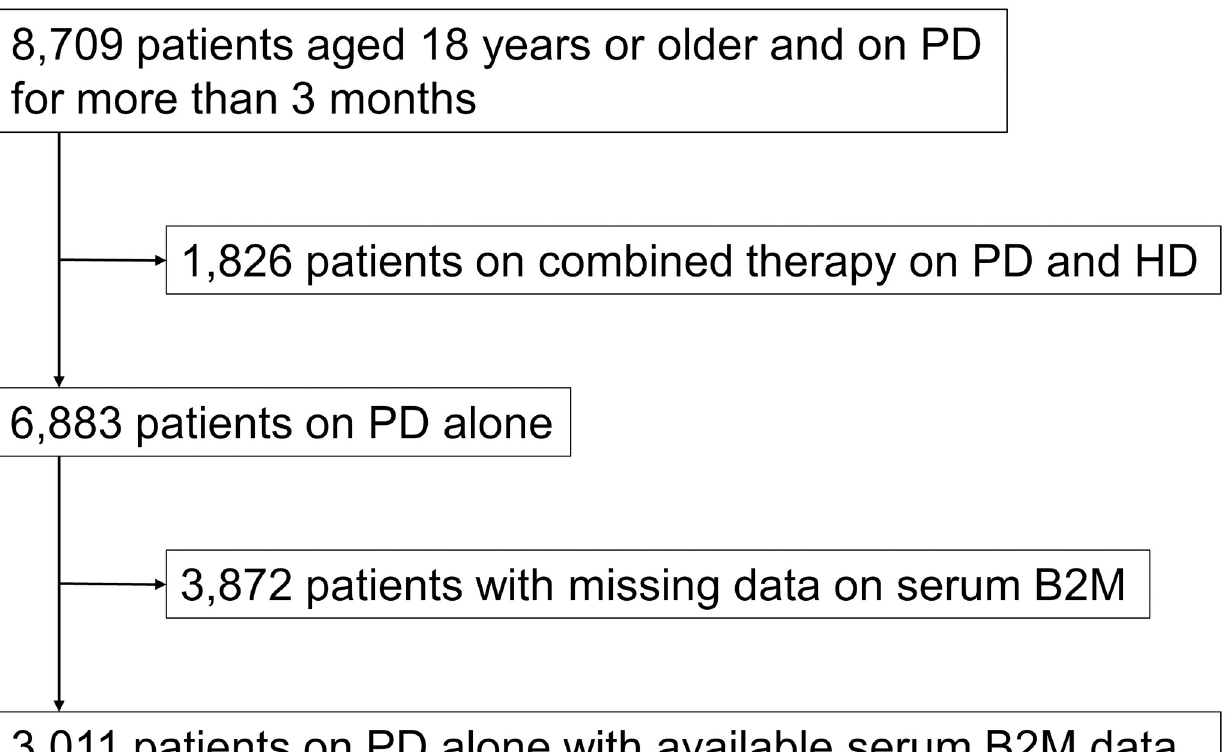
Fig 1. Patient selection flowchart. Abbreviations: PD, peritoneal dialysis; HD, hemodialysis; B2M, β 2 microglobulin.